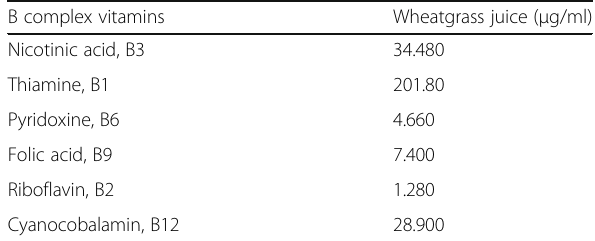
Table 3 Vitamins B complex of wheatgrass juice